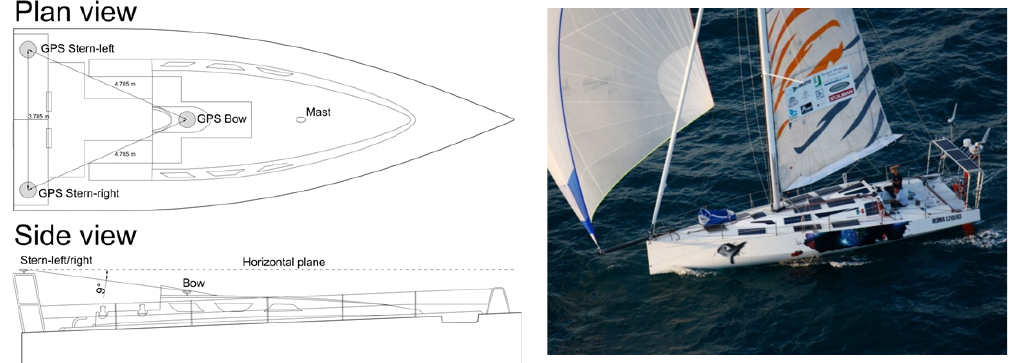
Figure 1. Plan view of the sailboat ECO40 and of the three GPS antennas ( Top Left ) and side view of the sailboat ( Bottom Left ); and ( Right ) a picture of the sailboat ECO40 during a test.